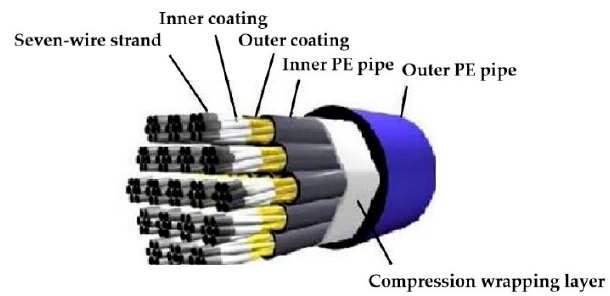
Figure 2. Details of hangers consisting of seven-wire strands.